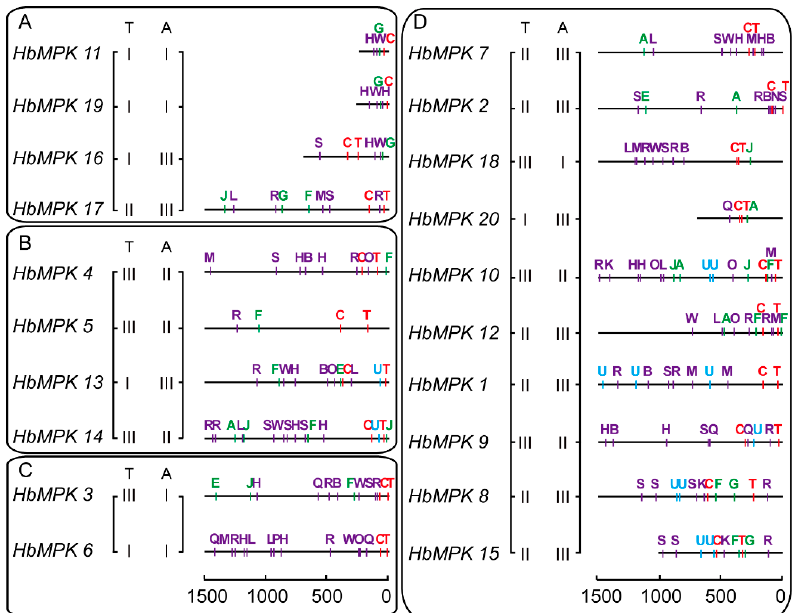
Figure 9. Distribution of cis -elements in the promoter regions of HbMPK genes. The HbMPKs were separated into four groups according to phylogenetic subfamily (groups A–D). The numerals in two parallel columns represent the cluster in the HbMPKs expression profiles in Figure 8. Coloured capital letters represent different cis -elements at corresponding positions. Red, green, purple, and blue letters represent the transcription initiation, phytohormone response, stress response, and high transcription classifications of cis -elements, respectively. Detailed information for each cis -element provided (Supplementary Table S2).